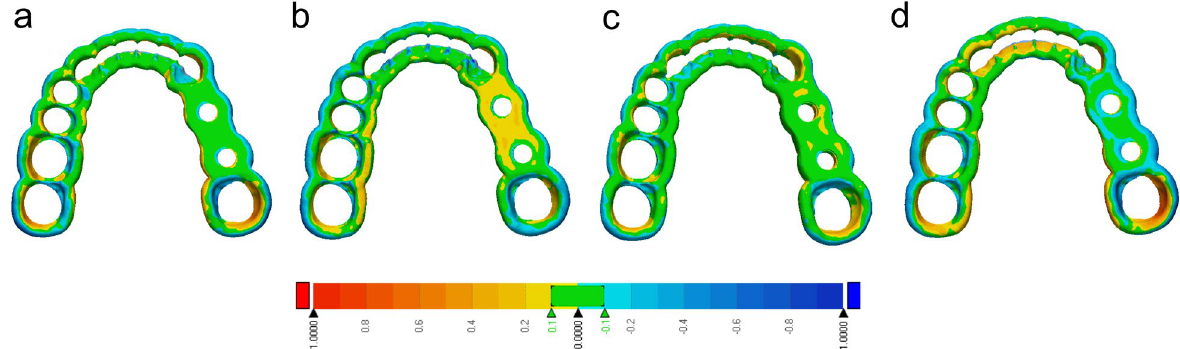
Figure 10. Exemplary visualization of heatmaps indicating the deviation of surgical guides of group Rt ( a ), At ( b ), Atm ( c ), and Bt ( d ) after annealing and steam sterilization. Areas in green show deviations below 0.1